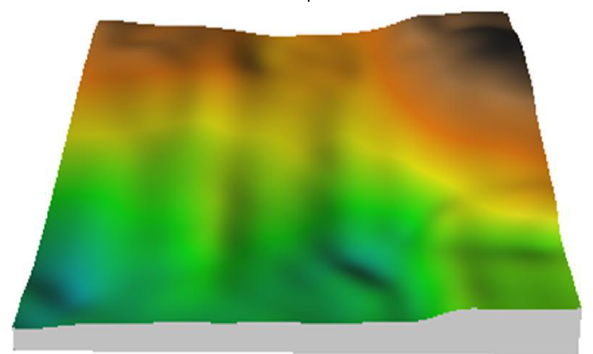
Figure 10. Left image shows new data points which were created by using raster to point conversion tool on Grass. Right image shows new elevation model which is created by using new data points.